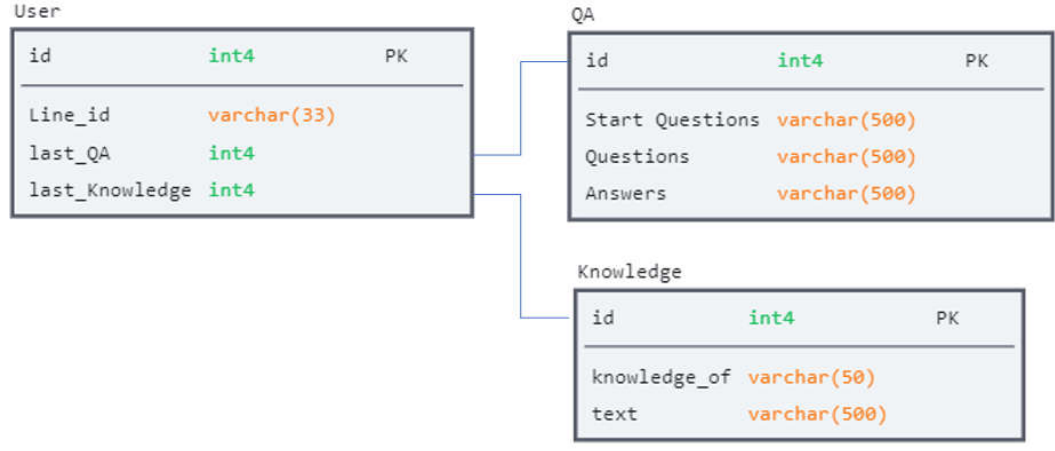
Figure 2. The diagram of the relationship.